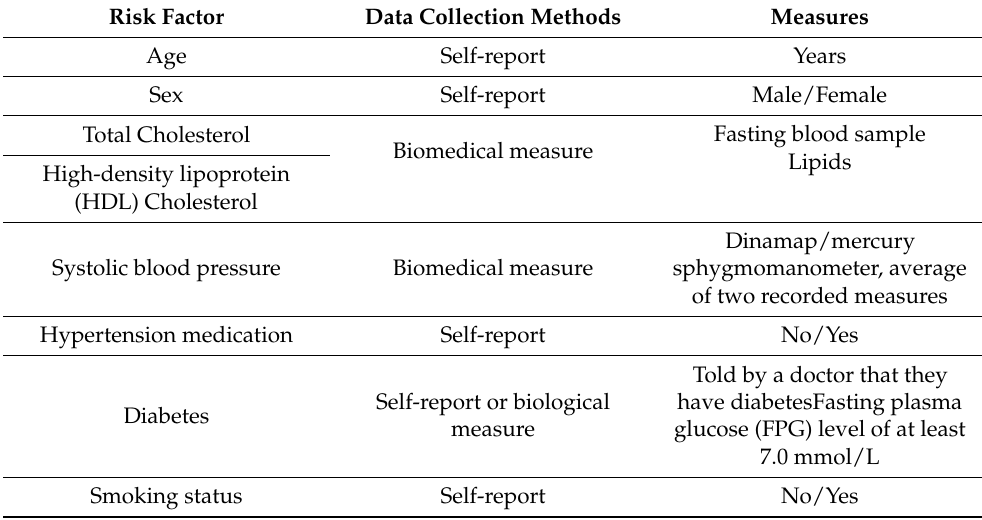
Table 1. Data collection methods and measures for the cardiovascular disease (CVD) risk factor variables used in the analysis. Risk Factor Data Collection Methods